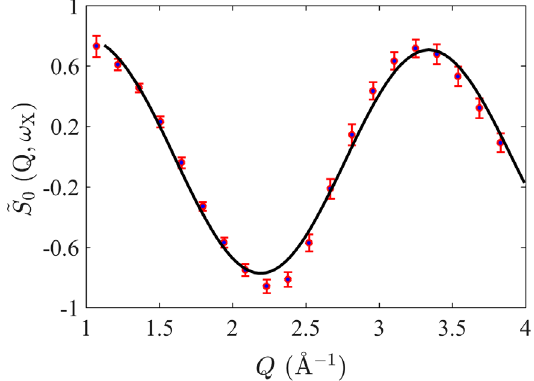
˜ S 0 ð Q; ω Þg in Fig. 6 in 0 . 15 Å − 1 FIG. 8. Points: Data from Im f bins for ω ¼ 40 . 3 (cid:2) 1 . 0 × 10 12 rad = s. Line: Fit using Eq. (2) finds the vibrational mode centered at R ¼ 2 . 79 (cid:2) 0 . 07 Å with vibrational motion amplitude A ¼ 0 . 164 (cid:2) 0 . 01 Å. For compari- son, the iodine ground state has an equilibrium separation of 2.67 Å, and the molecular potential well width varies from 0.173 Å at v ¼ 1 to 0.335 Å at v ¼ 5 [17].